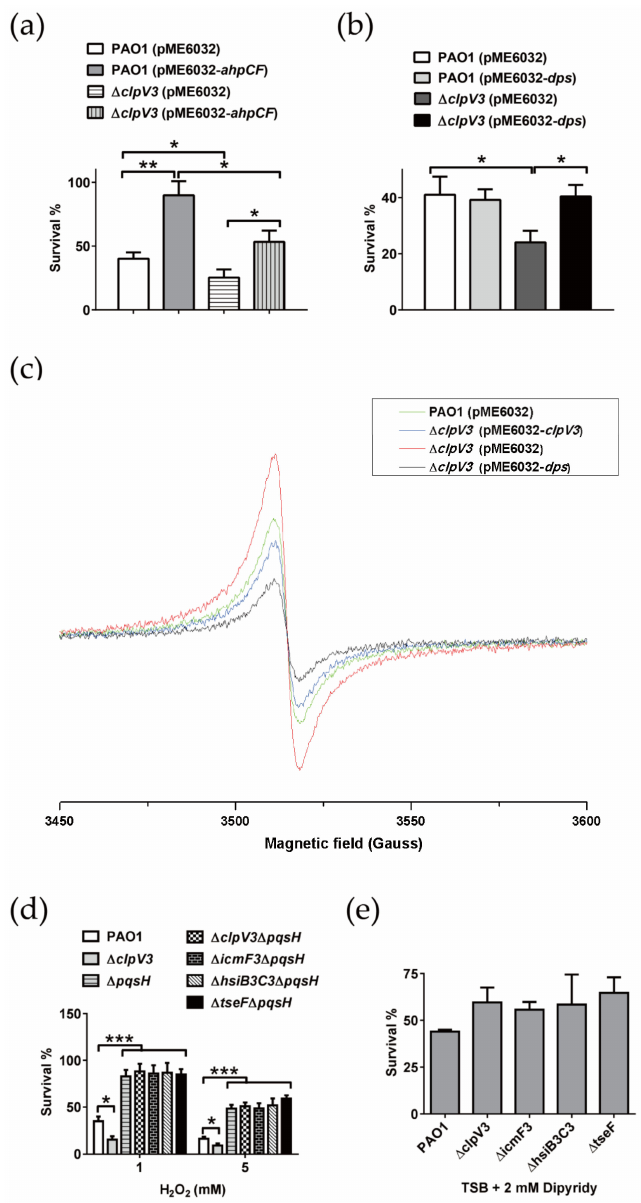
Figure 4. H3-T6SS combats H 2 O 2 stress in two ways. ( a , b ) Survival rates of the P. aeruginosa PAO1 (pME6032), ∆ clpV3 (pME6032), PAO1 (pME6032- ahpCF ), ∆ clpV3 (pME6032- ahpCF ), PAO1 (pME6032- dps ) and ∆ clpV3 (pME6032- dps ) strains were determined after exposure to 1 mM H 2 O 2 for 1 h. If needed, 1 mM isopropyl- β - D -1-thiogalactopyranoside (IPTG) was included in the medium for induction. The data shown are the average of three independent experiments, and the error bars indicate the SD of three independent experiments. * denotes p < 0.05, and ** denotes p < 0.01. ( c ) Strains were cultured in TSB medium, and the intracellular free Fe 2+ content was determined via whole-cell electron paramagnetic resonance (EPR) analysis. P. aeruginosa PAO1 (pME6032) is shown in green, ∆ clpV3 (pME6032) is shown in red, ∆ clpV3 (pME6032- clpV3 ) is shown in blue, and ∆ clpV3 (pME6032- dps ) is shown in black. ( d ) The PQS-deficient mutant reduced the sensitivity of the H3-T6SS mutants to H 2 O 2 . The survival rates of the relevant P . aeruginosa strains were determined after exposure to 1 mM or 5 mM H 2 O 2 for 1 h. ( e ) Survival rates of the relevant P. aeruginosa strains grown in TSB with 2 mM dipyridyl were determined after exposure to 1 mM H 2 O 2 for 1 h. The data shown are the average of three independent experiments, and the error bars indicate the SD of three independent experiments. * denotes p < 0.05, and *** denotes p <